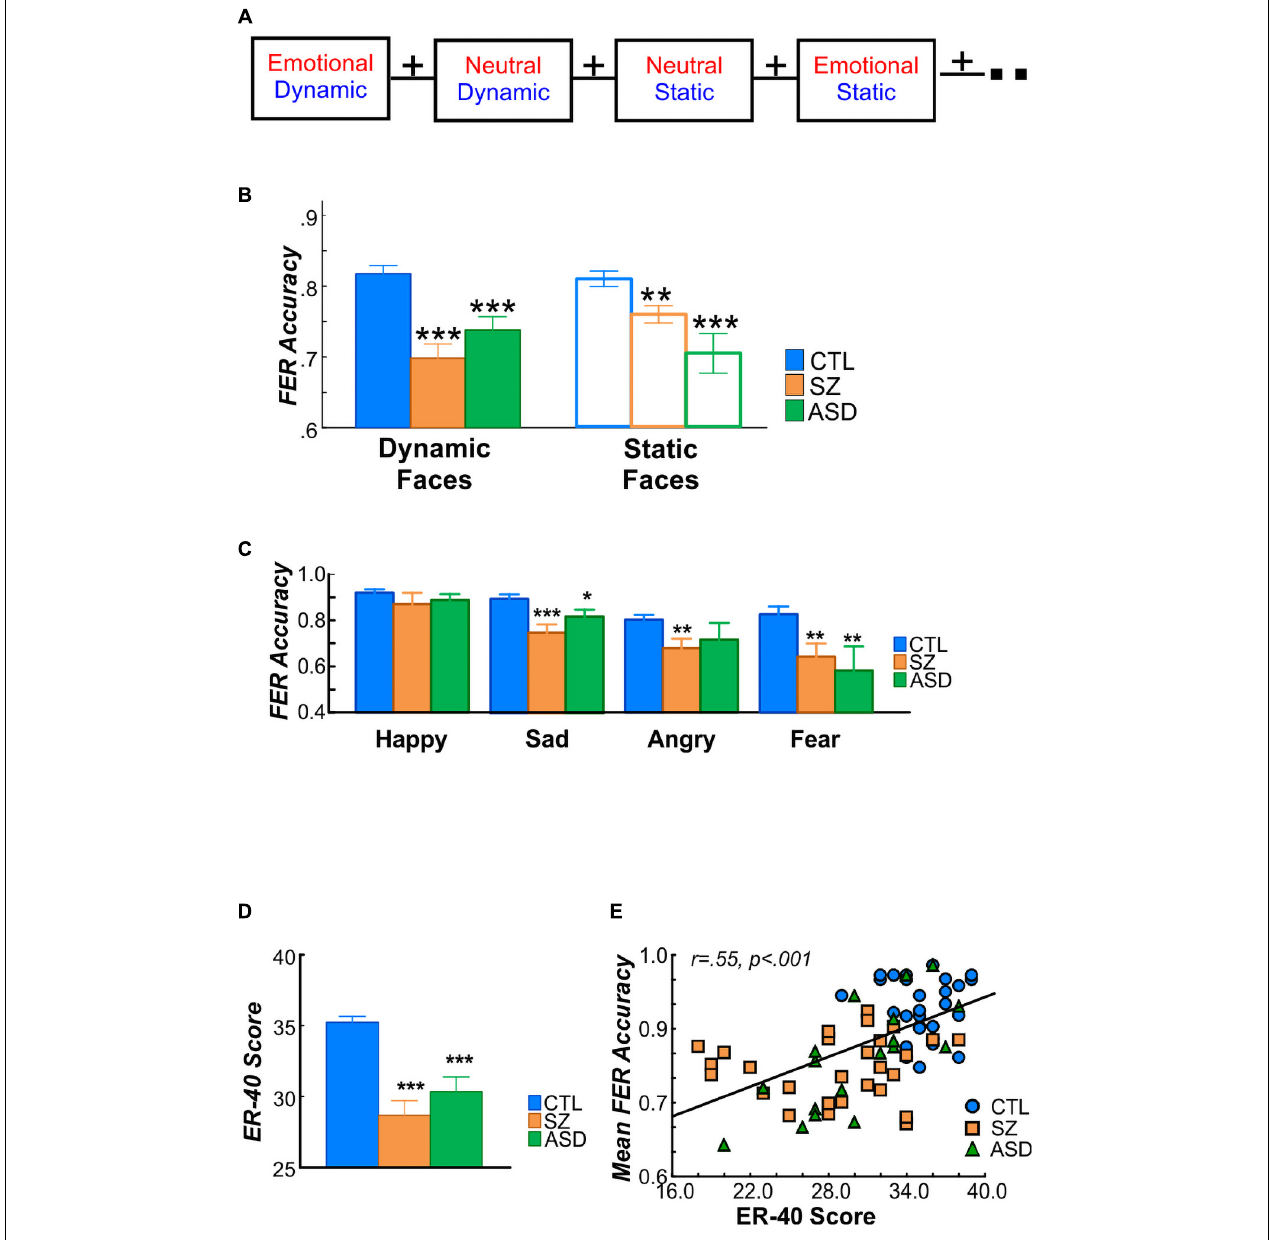
FIGURE 1 | (A) Schematic of fMRI paradigm. A total of 20 blocks lasting 12 s each were delivered in random order in each of two fMRI scans. Each block consisted of faces expressing a single emotion (happy, sad, angry, fear) or neutral expression either dynamically or statically. (B) FER accuracy determined in the behavioral paradigm administered outside the scanner, for dynamic (filled bars) and static (open) faces in control (CTL; blue), schizophrenia (SZ; orange), and autism (ASD; green). Relative to the CTL group, FER accuracy was significantly lower in the SZ and ASD groups for both dynamic (left bars) and static (right) faces. In SZ patients, FER accuracy for dynamic faces was especially reduced, relative to control participants. (C) Mean FER accuracy as a function of face-emotion and (below) sample stimuli used for happy, sad, angry and fear emotions. FER accuracy did not differ overall as a function of face-emotion and group membership. (D) Groupwise scores on the Penn Emotion Recognition (ER-40) test. As expected, both SZ and ASD participants had significantly lower ER-40 scores compared to the CTL group, which, (E) were correlated with accuracy on the FER task. In all cases, significance of group differences is denoted by asterisks, relative to CTL (* p < 0.05; ** p < 0.01;*** p <